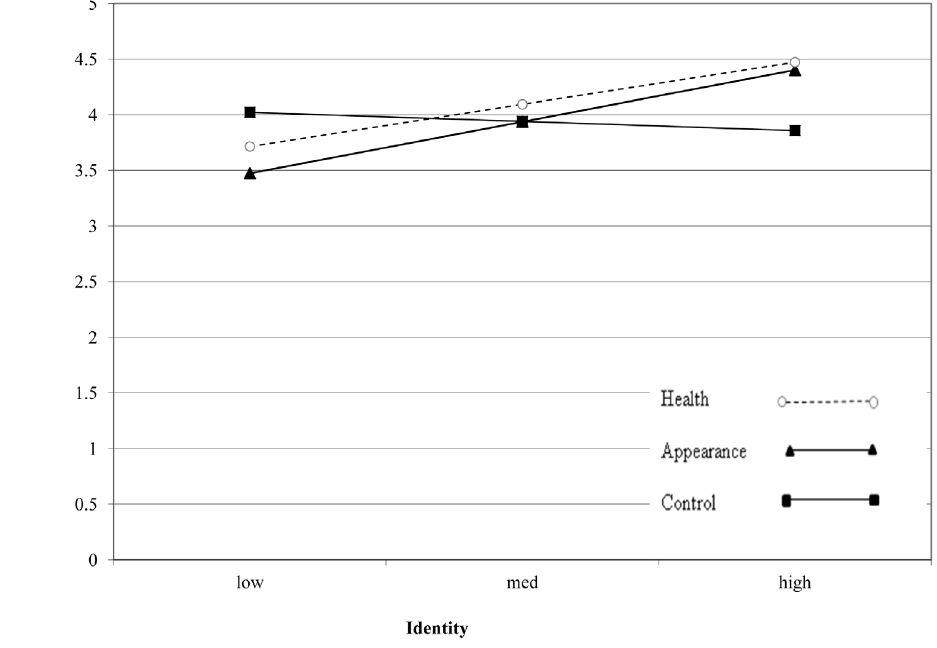
Figure 1. Simple slopes graph showing the relationship between REI-Attractiveness and identity by experimental condition.